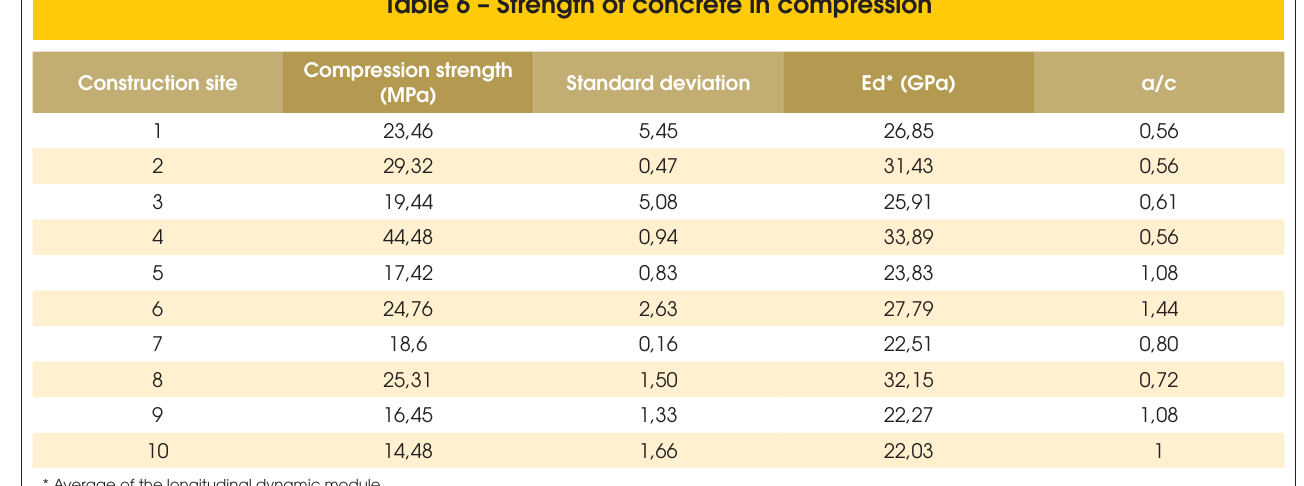
Table 6 – Strength of concrete in